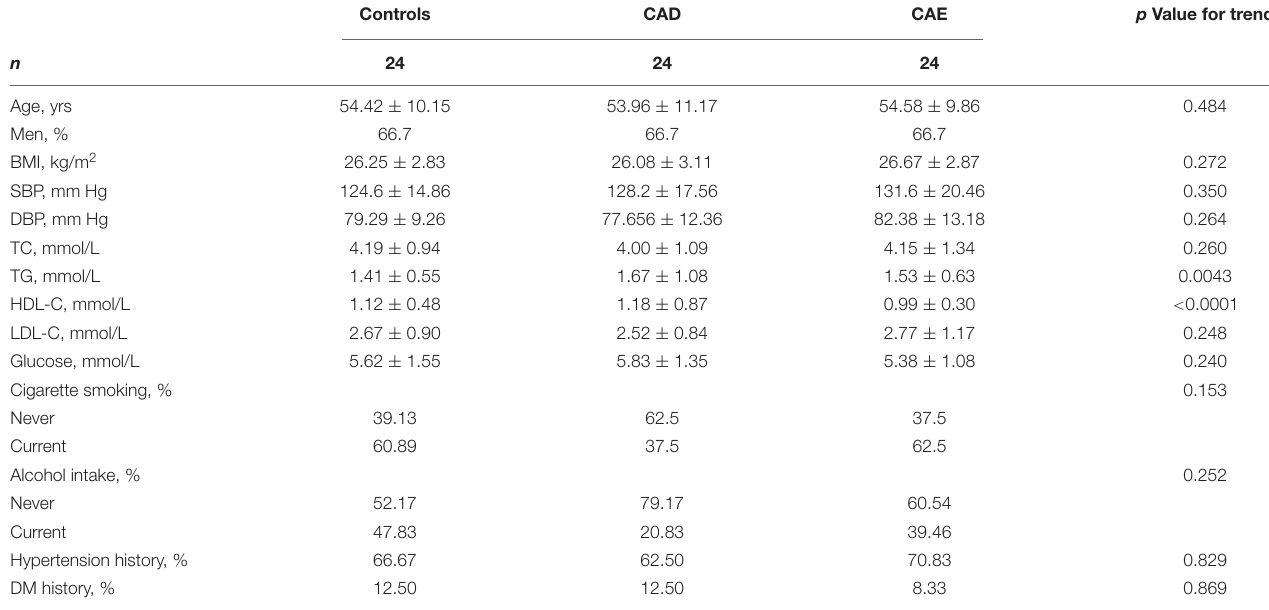
TABLE 1 | Baseline characteristics of patients in the discovery sets.